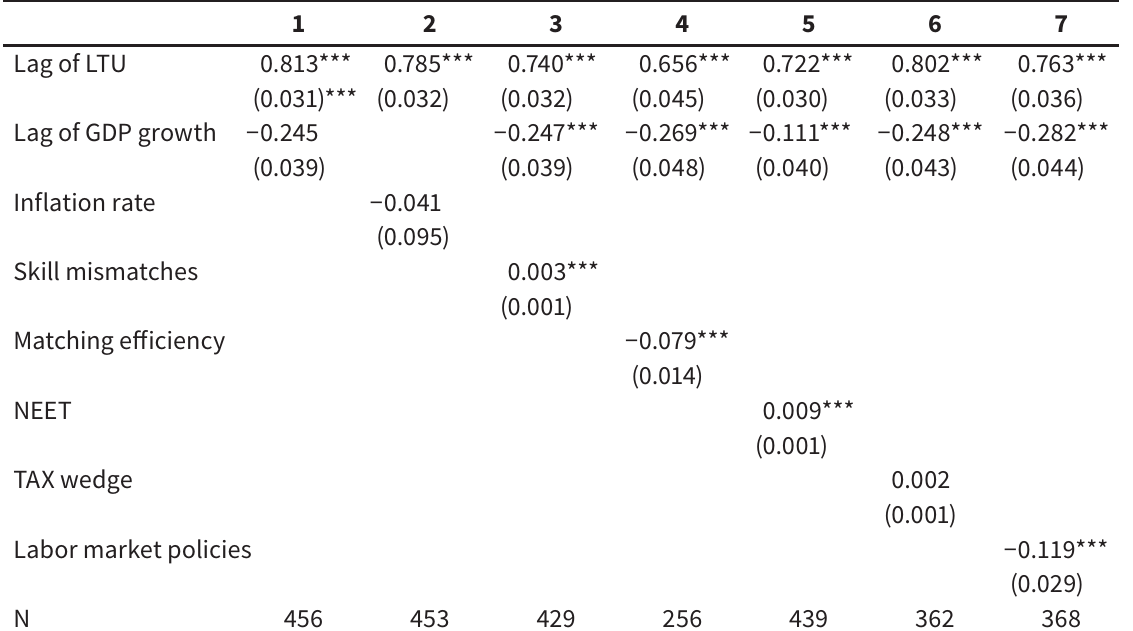
Table 2 Simple regressions Dependent Variable: Incidence of